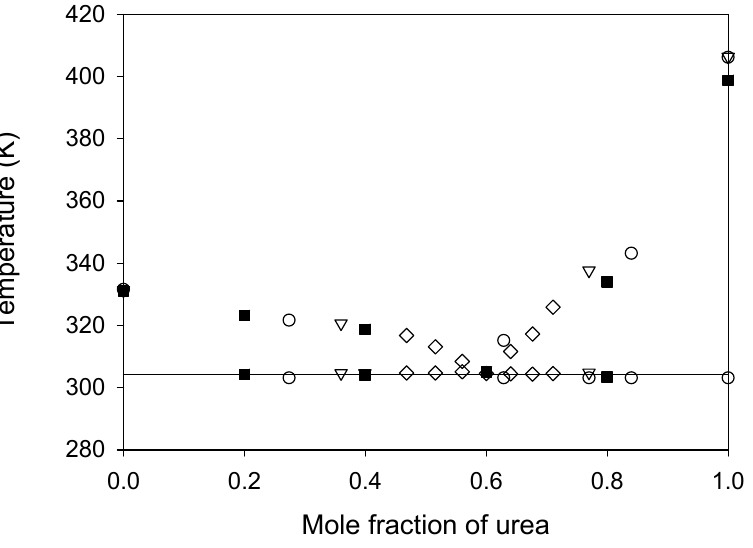
Mole fraction of urea Figure 2. Temperature–composition diagram for the solid–liquid equilibrium of the urea + sodium Figure 2. Temperature–composition diagram for the solid–liquid equilibrium of the urea + sodium Figure 2. perature found. Figure 2. Temperature–composition diagram for the solid–liquid equilibrium of the urea + sodium Figure 2. Temperature–composition diagram for the solid–liquid equilibrium of the urea + sodium Figure 2. Temperature–composition diagram for the solid–liquid equilibrium of the urea + sodium acetate trihydrate system. Experimental results ( ) are compared to literature data: , ref. [24]; , acetate trihydrate system. Experimental results ( ) are compared to literature data: , ref. [24]; , acetate trihydrate system. Experimental results ( ) are compared to literature data: , ref. [24]; , acetate trihydrate system. Experimental results ( ) are compared to literature data: acetate trihydrate system. Experimental results ( ) are compared to literature data: , ref. [24]; , ref. [28]; , ref. [29]. The horizontal solid line represents the eutectic temperature found. ref. [28]; , ref. [29]. The horizontal solid line represents the eutectic temperature found. Table 2. Urea + sodium acetate trihydrate eutectic composition and melting temperature. ref. [28]; , ref. [29]. The horizontal solid line represents the eutectic temperature found. ref. [28]; , ref. [29]. The horizontal solid line represents the eutectic temperature found. , ref. [29]. The horizontal solid line represents the eutectic temperature found. Table 2. Urea + sodium acetate trihydrate eutectic composition and melting temperature. Table 2. Urea + sodium acetate trihydrate eutectic composition and melting temperature. Table 2. Urea + sodium acetate trihydrate eutectic composition and melting temperature. Table 2. Urea + sodium acetate trihydrate eutectic composition and melting temperature. Table 2. Urea + sodium acetate trihydrate eutectic composition and melting temperature. Eutectic Composition (Urea Mole